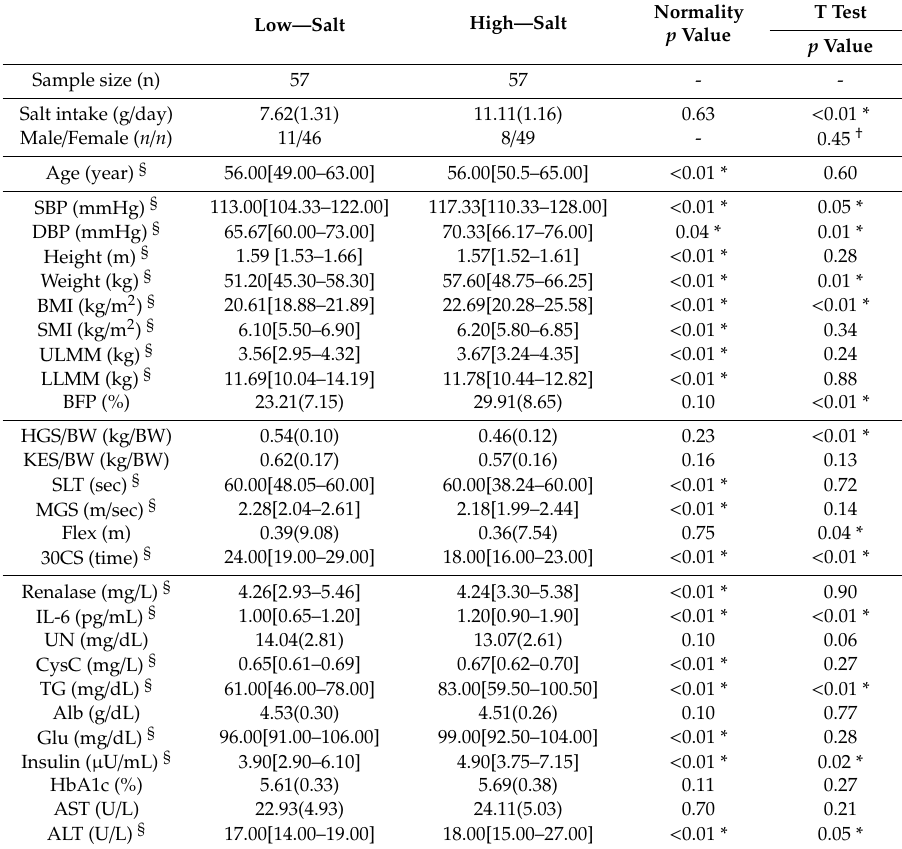
Table 1. Comparison of sarcopenia-related parameters by estimated salt